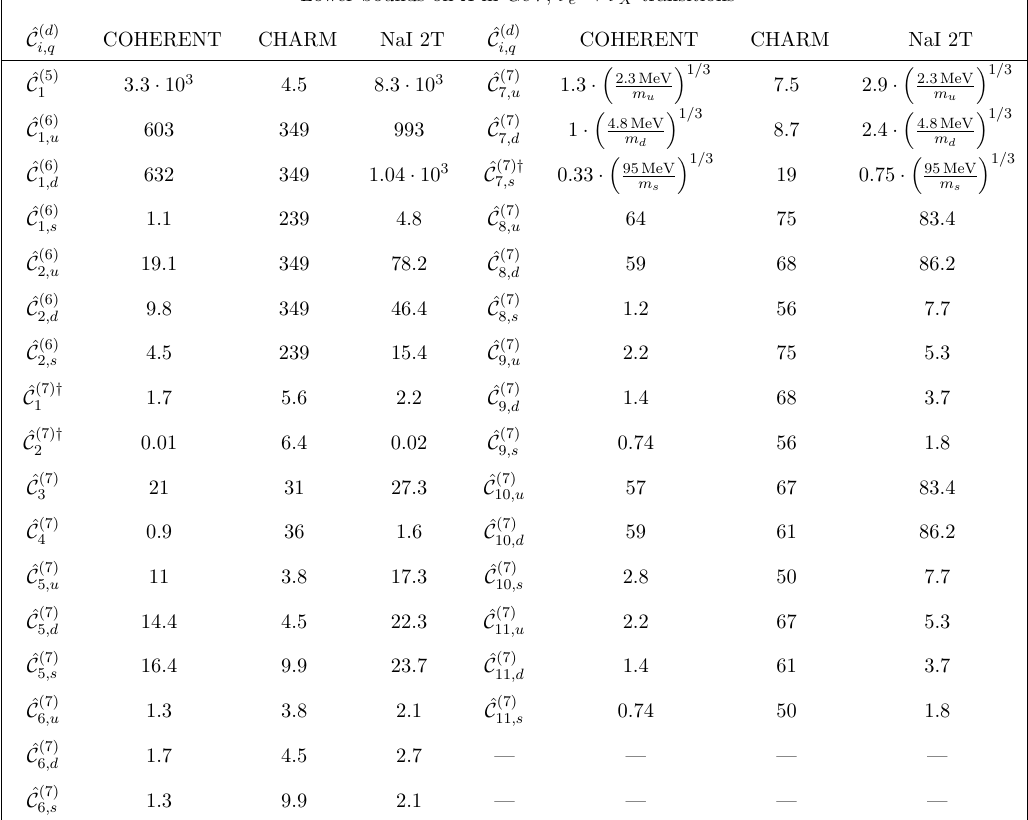
(cid:23) X , ! ( d ) ( d ) a , eq. (2.1), setting a = 1, C C ( ^ C (7) ) we use only the 7 ;s 1 ; 2